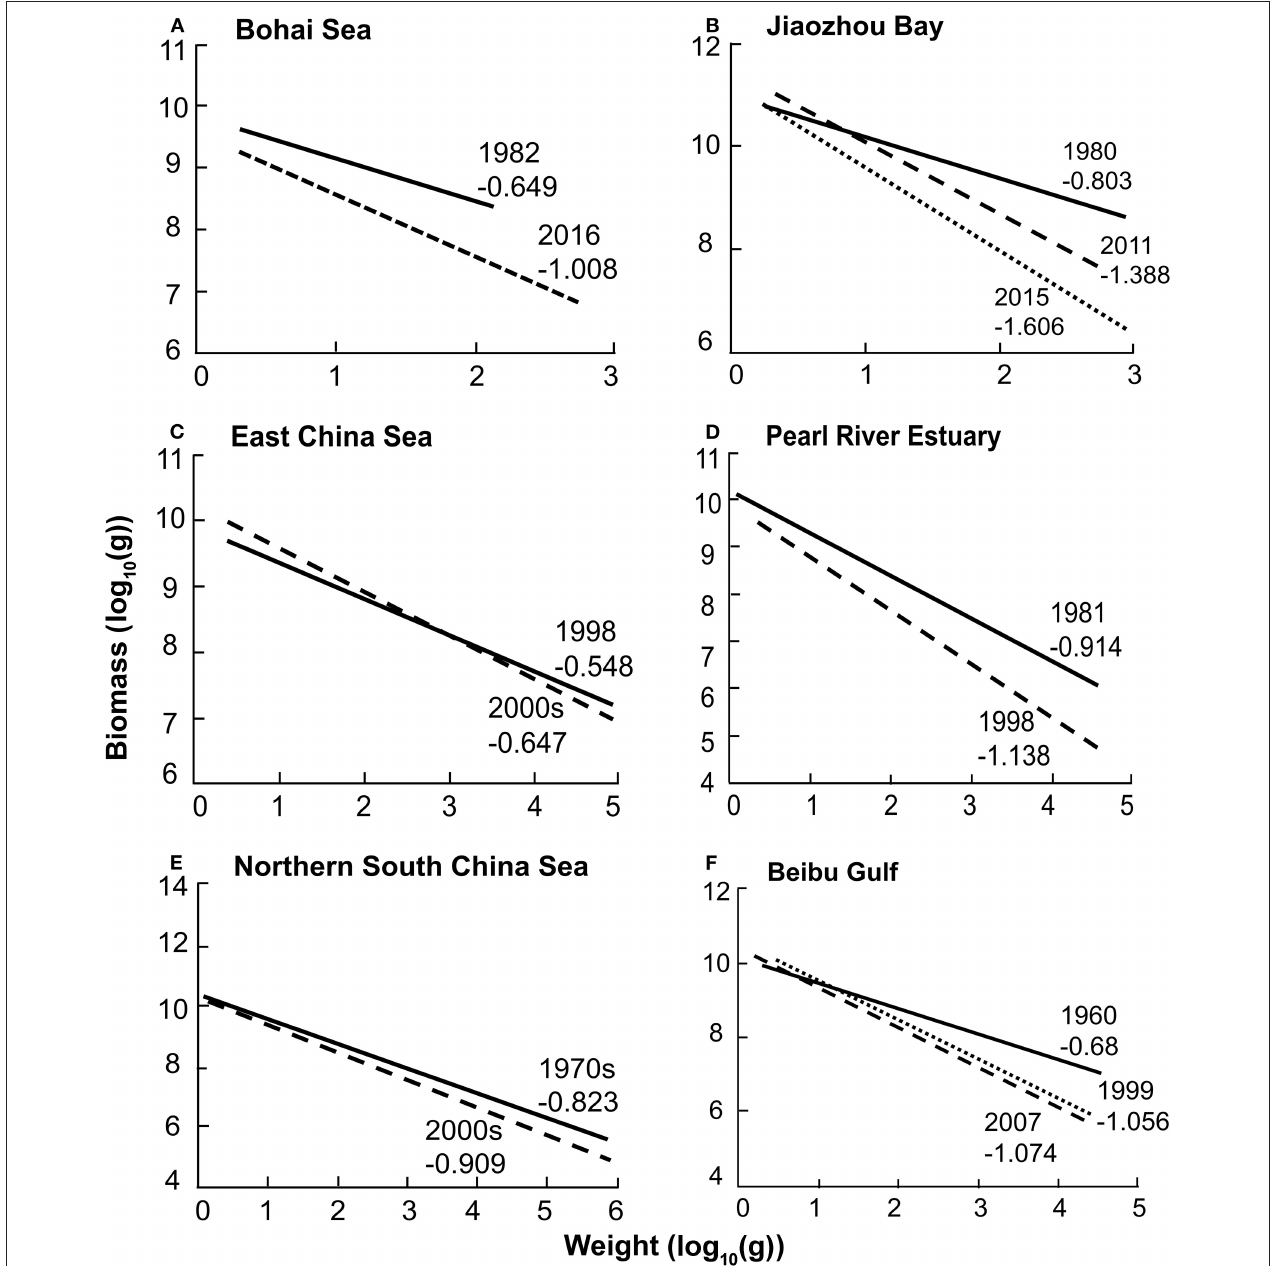
FIGURE 4 | Comparison of particle size distribution (PSD) slopes for 6six paired models in China’s seas from 1960s to 2010s. (A) Bohai Sea; (B) Jiaozhou Bay; (C) East China Sea; (D) Pearl River Estuary; (E) Northern South China Sea; (F) Beibu Gulf.